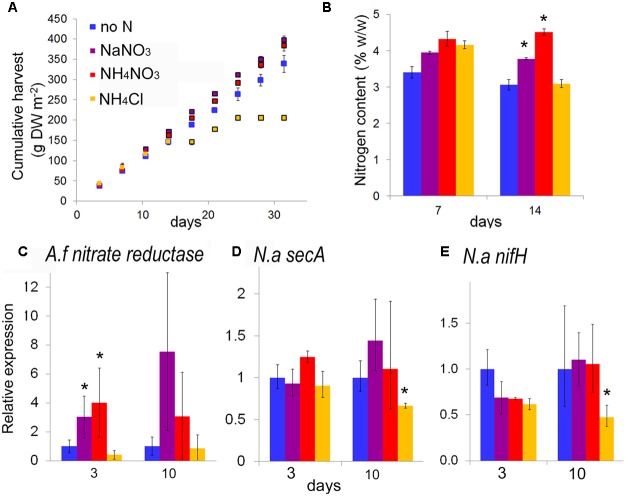
Azolla filiculoides response to N-fertilizer under continuous production conditions. Ferns were grown as in Figure 1 but this time in medium without (no N) or with 4 mM NaNO3, or 2 mM NH4NO3, or 4 mM NH4Cl. Biomass harvested was split to determine cumulative harvest (A) nitrogen content (B) and to extract mRNA. Reverse transcription of the RNA was with an excess random hexamers to analyze levels of A. filiculoides and Nostoc azollae transcripts by quantitative PCR: A. filiculoides nitrate reductase Afcontig 35782 (C), N. azollae secA
(D) and nifH
(E). Standard deviation is for n = 3, T-test significance with reference to no N for P < 0.05 is marked with ∗.